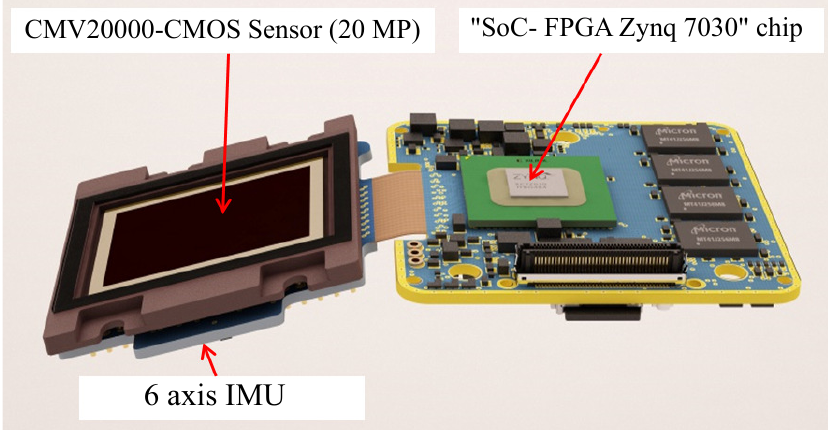
Figure 2. The CMOS sensor with the inertial sensors and the embedded